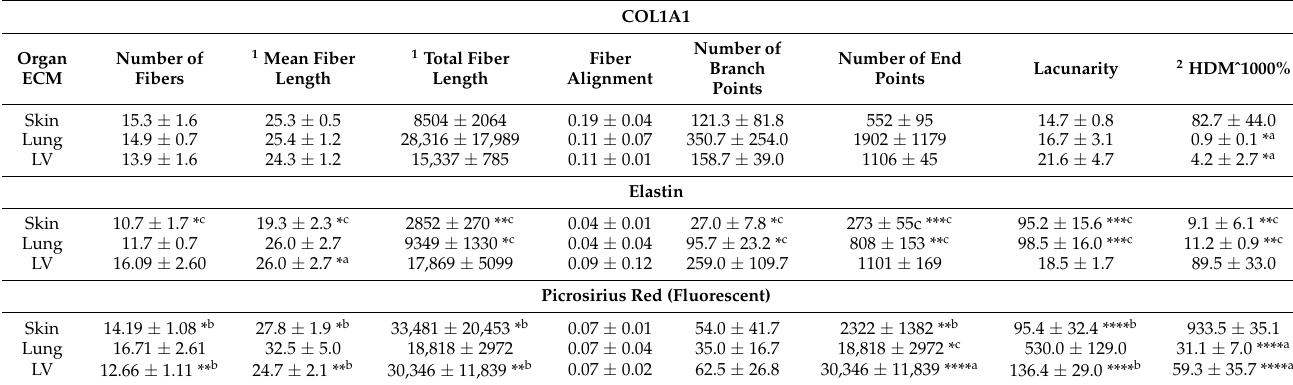
Figure 8. Fluorescent micrographs of PSR stained skin, lung and LV ECM hydrogels. ( a ) Unstained sections (autofluorescence); ( b ) PSR-stained sections. Original objective magnification 40×. Table 2. Results from TWOMBLI